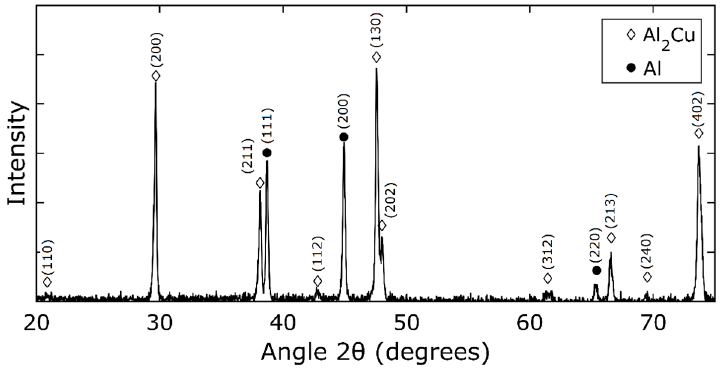
Figure 14. XRD pattern obtained from non-corroded EC sample.